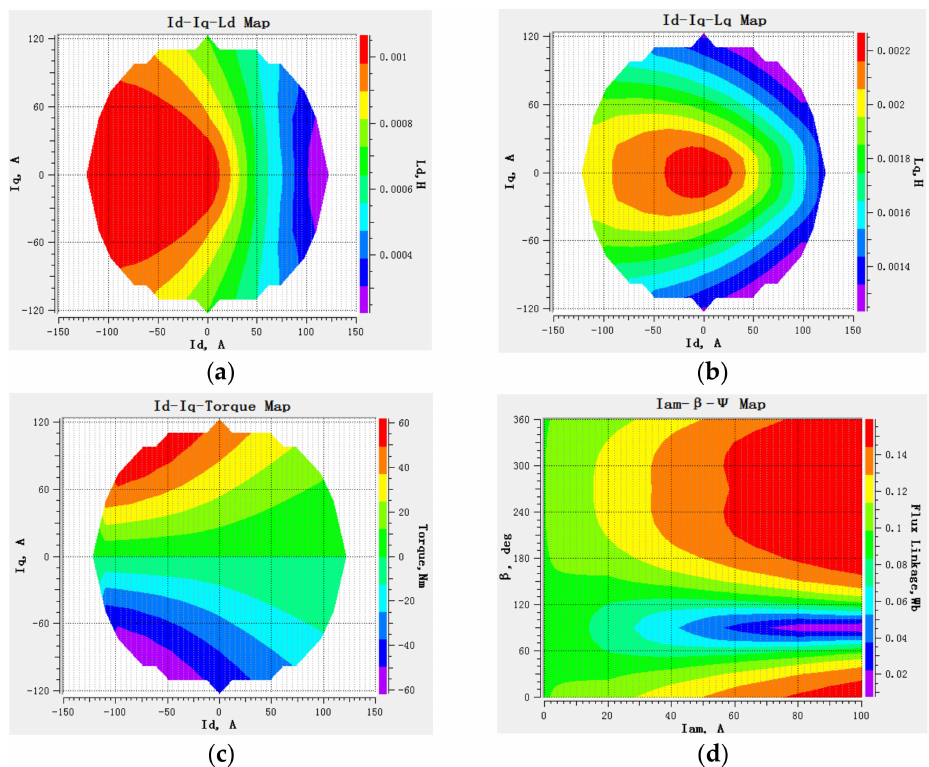
Figure 6. Distribution diagram of various parameters of motor model: ( a ) I d distribution map; ( b ) I q distribution map; ( c ) Electromagnetic torque distribution map; ( d ) Flux linkage distribution